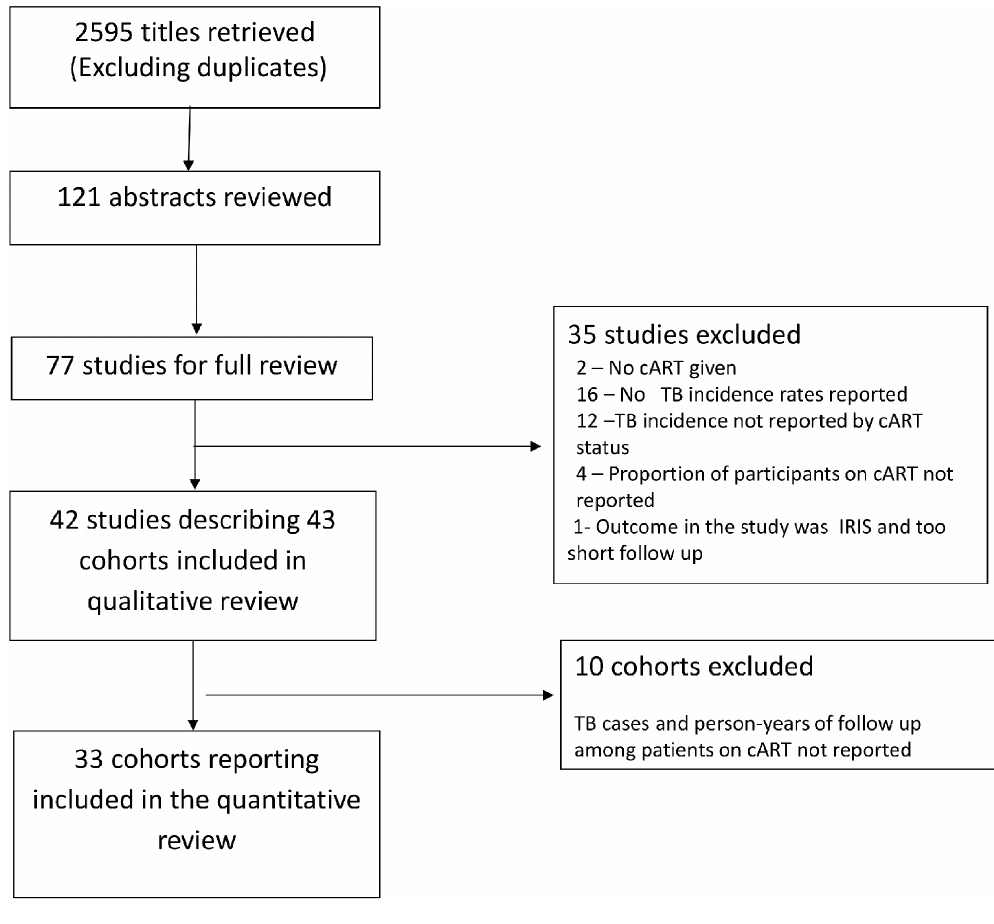
Figure 1. Summary of search findings.